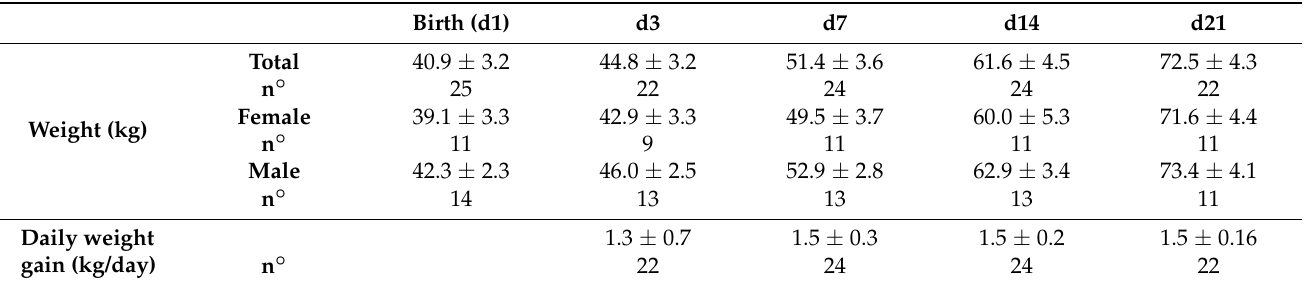
Table 6. Weight and DWG monitored at birth and at 3, 7, 14, and 21 days after